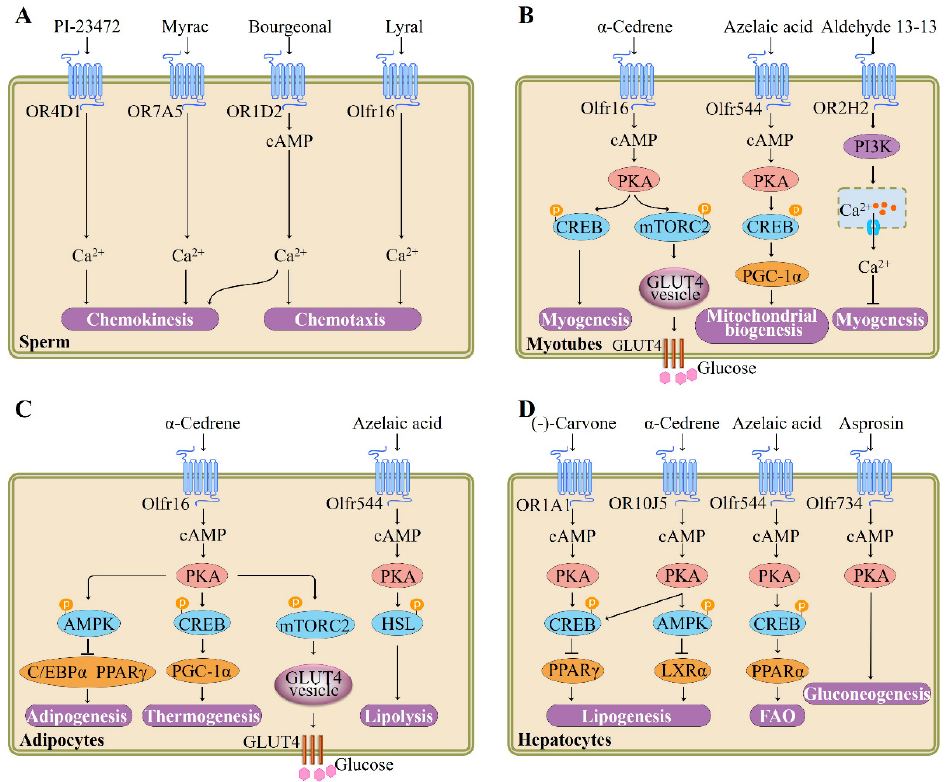
Figure 2. Summary of signaling pathways and functions regulated by ectopic ORs in sperm, myotubes, adipocytes, and hepatocytes. ( A ) Activation of OR4D1, OR7A5, OR1D2, or olfr16 modulates sperm chemotaxis or chemokinesis, adapted from [5,42,43], published by AAAS, 2003; American Society for Biochemistry and Molecular Biology, 2011; The Company of Biologists, 2004. ( B ) Stimulation of olfr16 by α -cedrene in myotubes promotes myogenesis and increases GLUT4-mediated glucose uptake. In addition, olfr544 and OR2H2 activation induces mitochondrial biogenesis and inhibits myogenesis, respectively, adapted from [36,44,45], published by Wiley, 2018; MDPI, 2014 and Elsevier, 2018. ( C ) Regulation of adipogenesis, thermogenesis, GLUT4-mediated glucose uptake, or lipolysis by olfr16 or olfr544, adapted from [18,35], published by MDPI, 2018 and MDPI, 2017. ( D ) ORs (OR1A1, OR10J5, olfr544, or olfr734) can modulate hepatic lipogenesis, fatty acid oxidation (FAO), or gluconeogenesis, adapted from [12,46,47], published by Elsevier, 2015; Nature Portfolio, 2017 and Cell Press, 2019. AMPK, adenosine monophosphate (AMP)-activated protein kinase; cAMP, cyclic adenosine monophosphate; CREB, cAMP-responsive element-binding protein; C/EBP α , CCAAT/enhancer-binding proteins α ; HSL, hormone-sensitive lipase; GLUT4, glucose transporter type 4; mTORC2, mammalian target of rapamycin complex 2; PKA, protein kinase A; PPAR, peroxisome proliferator-activated receptor; PI3K, phosphoinositide 3-kinase; PGC-1 α , peroxisome proliferator-activated receptor γ coactivator